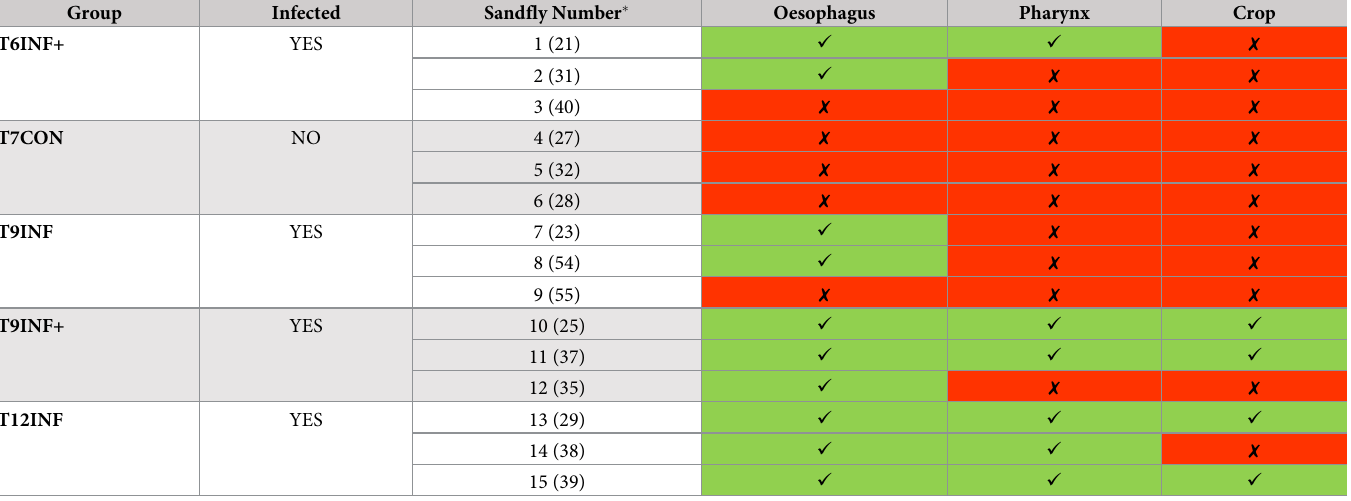
� Numbers in brackets are experimental codes for each sand